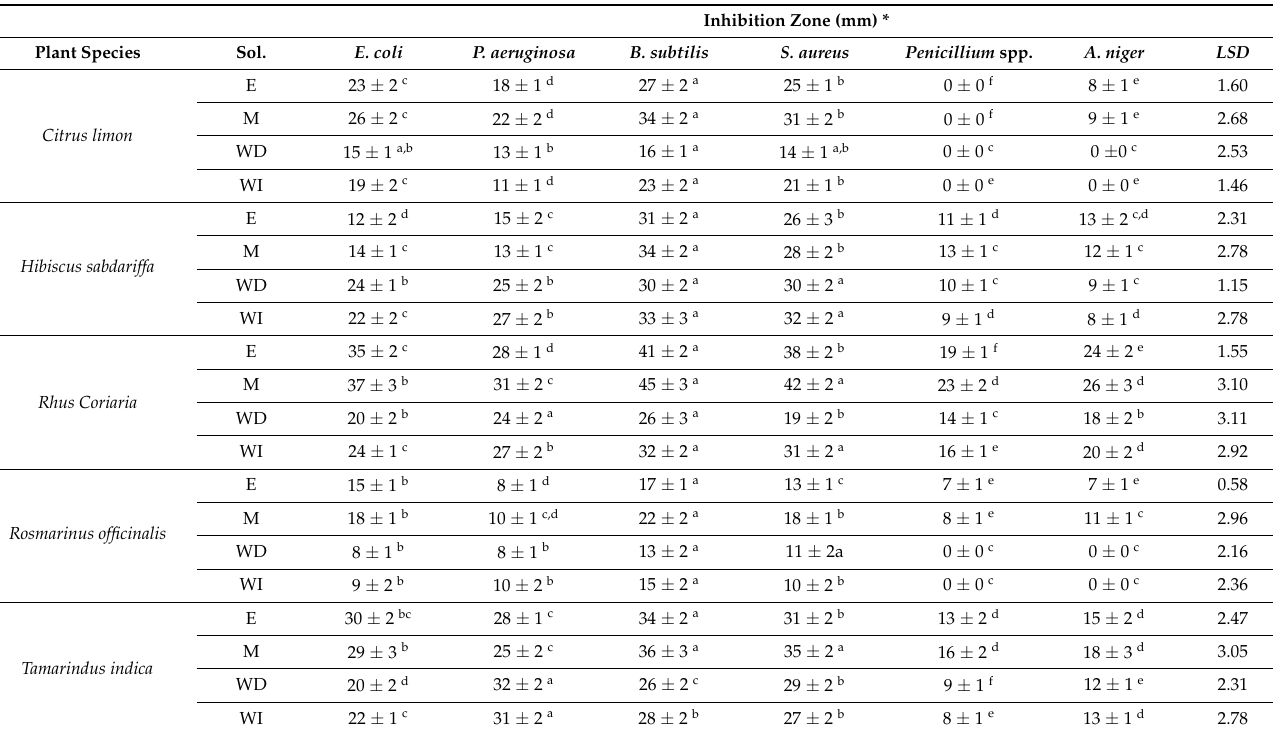
Table 3. Antimicrobial activity of plant extracts by the disc diffusion method. Inhibition Zone (mm)